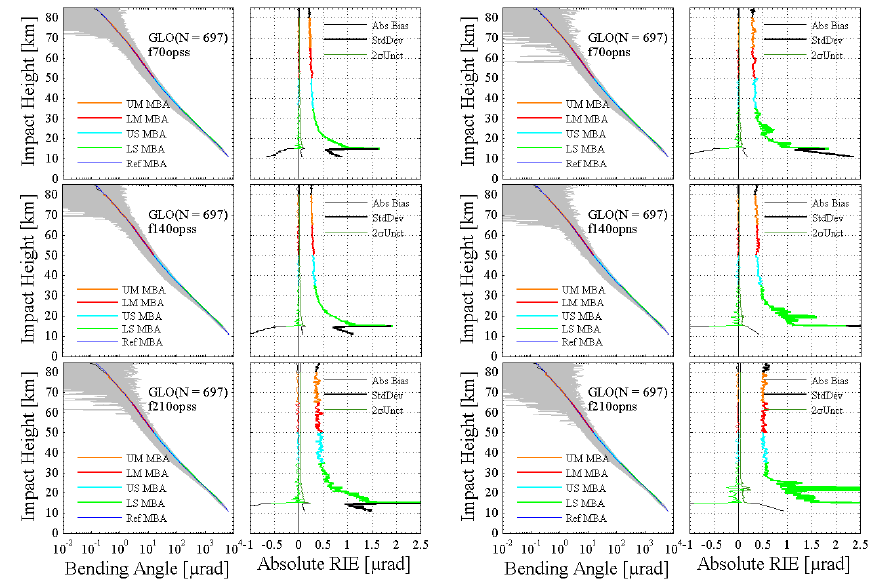
Figure 6. Ionosphere-corrected bending angle profiles and their statistical results for the global ensemble “opss” data set (left) and “opns” data set (right), respectively. In both composite panels, the left column illustrates the ionosphere-corrected bending angle profiles (mean reference bending angle (blue line), ensemble bending angles (grey lines) and their mean bending angle (MBA) in the UM (orange), LM (red), US (cyan) and LS (green)) under low (top), medium (middle) and high (bottom) solar activity levels. The right column shows their corresponding statistical RIE results including the bias (thin lines), standard deviation (thick lines) and the bias’ 95% confidence level uncertainty (dark green lines).